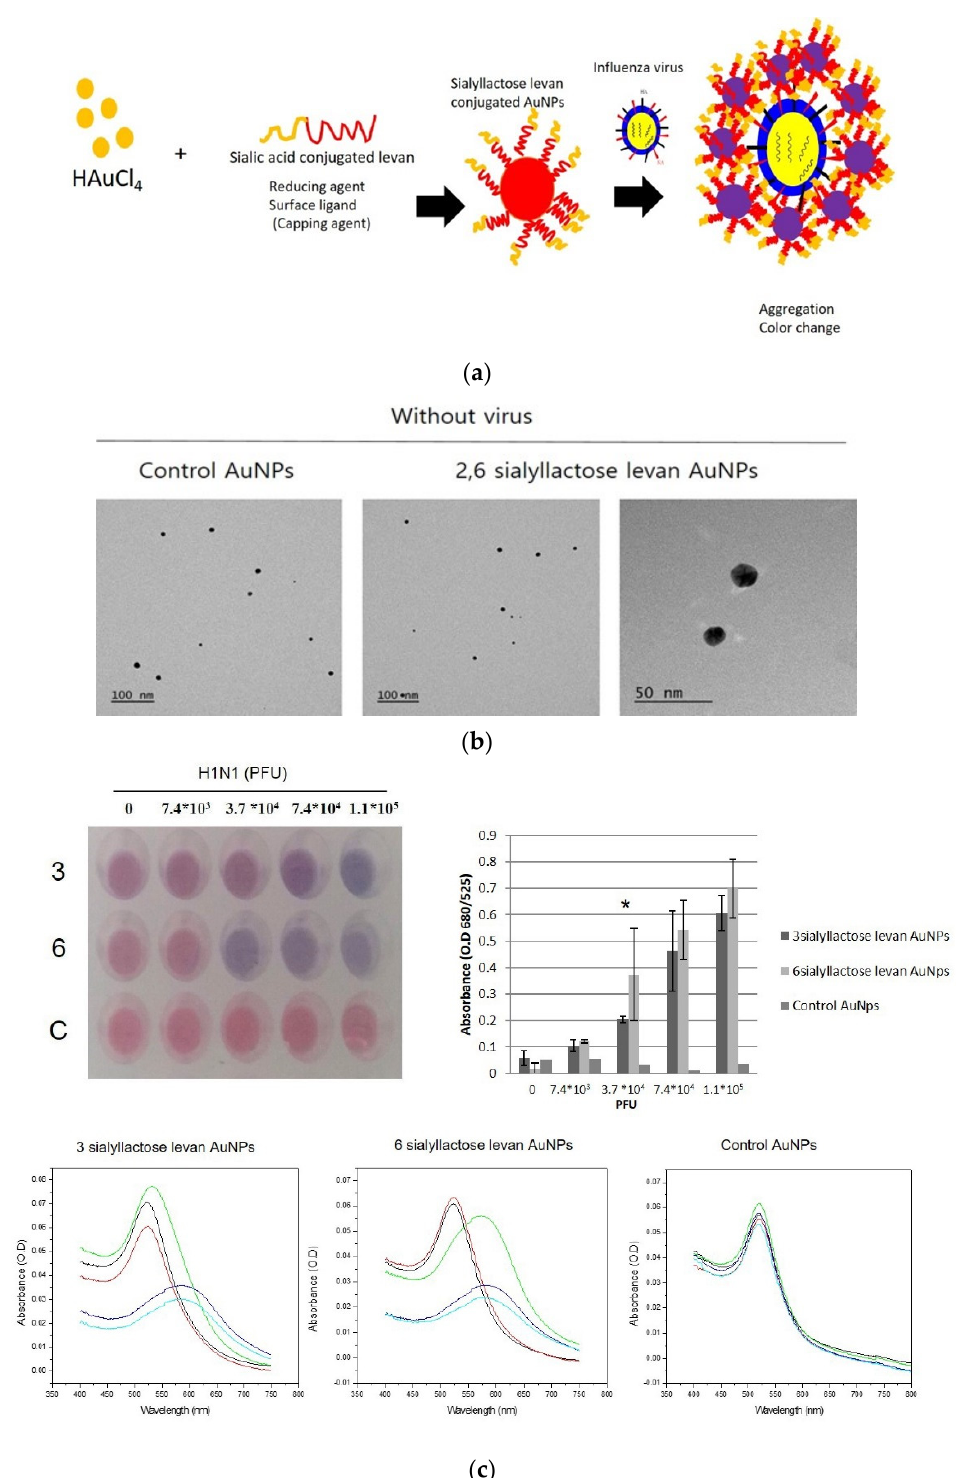
Figure 3. The formation and interaction of AuNPs with influenza virus ( a ). TEM images of synthesized AuNPs ( b ). UV-vis and relative absorbance ratios (Abs 680/Abs 525) (H1N1 concentration: black, 0; red, 7.4 × 10 3 pfu; green, 3.7 × 10 4 pfu; blue, 7.4 × 10 4 pfu; sky blue, 1.1 × 10 5 pfu) ( c ). (* p < 0.05).